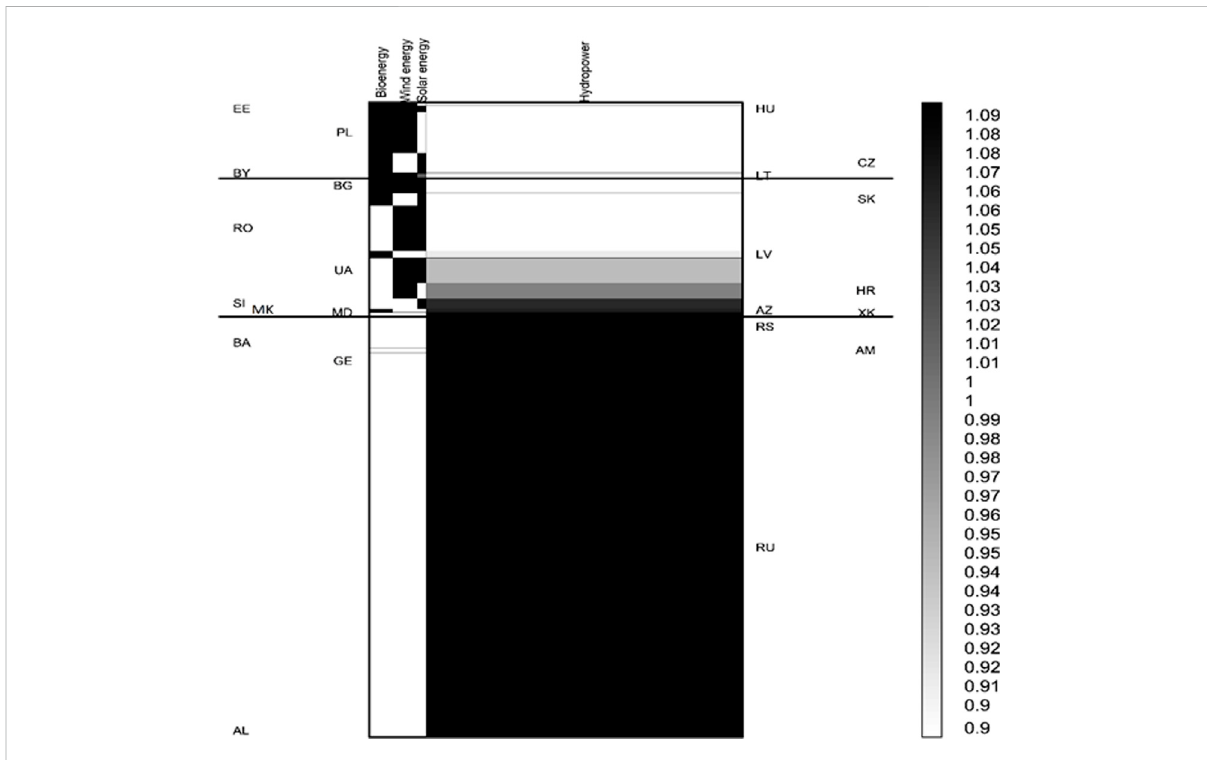
FIGURE 7 The use of various sources for renewable energy production in countries of Central and Eastern Europe in 2011 –